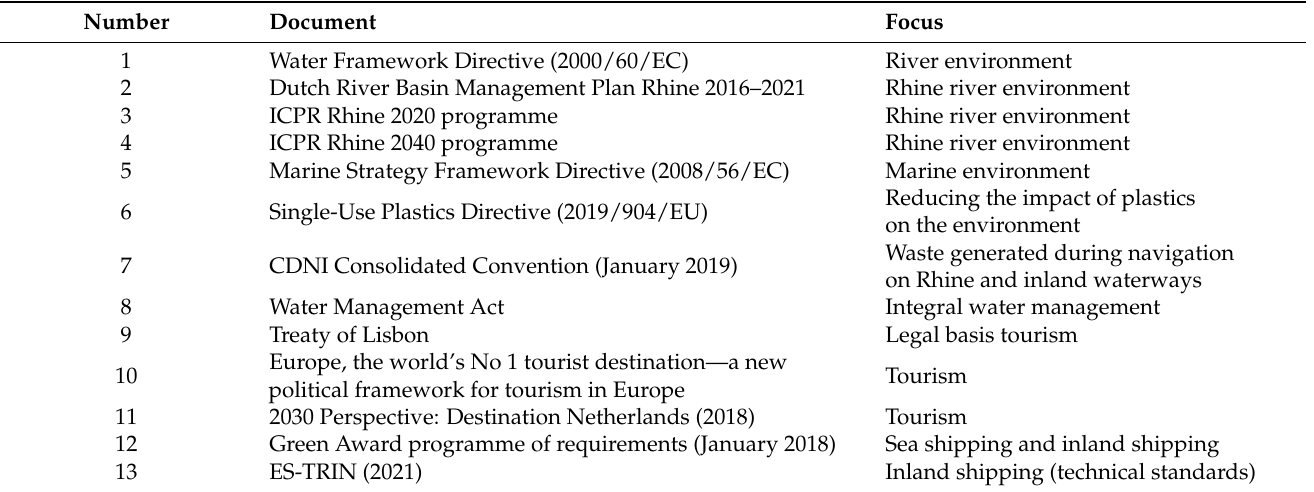
Table A1. Documents analysed.